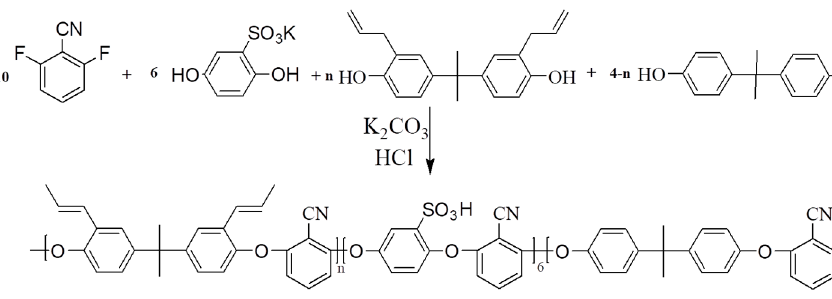
Table 1. Raw material ratio for the synthesis of side chain crosslinkable sulfonated poly(aryl ether nitrile) containing allyl bisphenol A with different molar fractions.